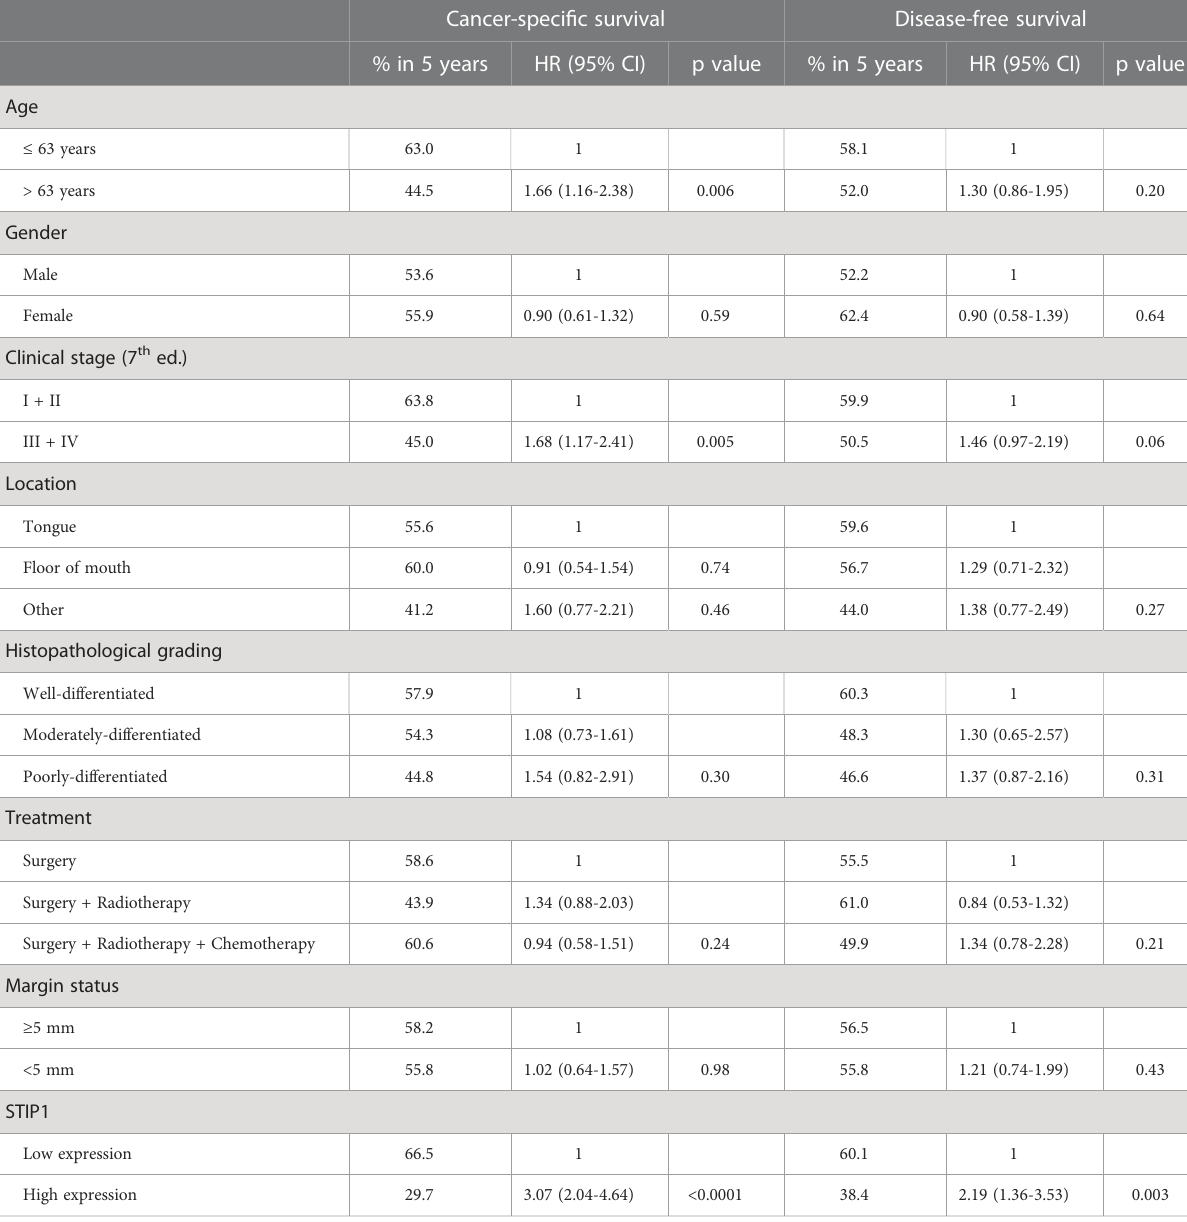
TABLE 2 Univariate analysis for cancer-speci fi c survival and disease-free survival of the patients with oral squamous cell carcinoma of cohort 2